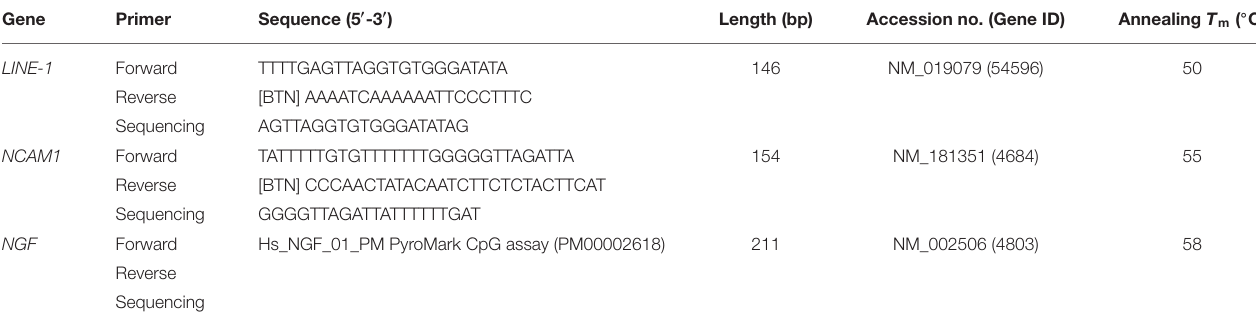
TABLE 1 | List of primers used for pyrosequencing.